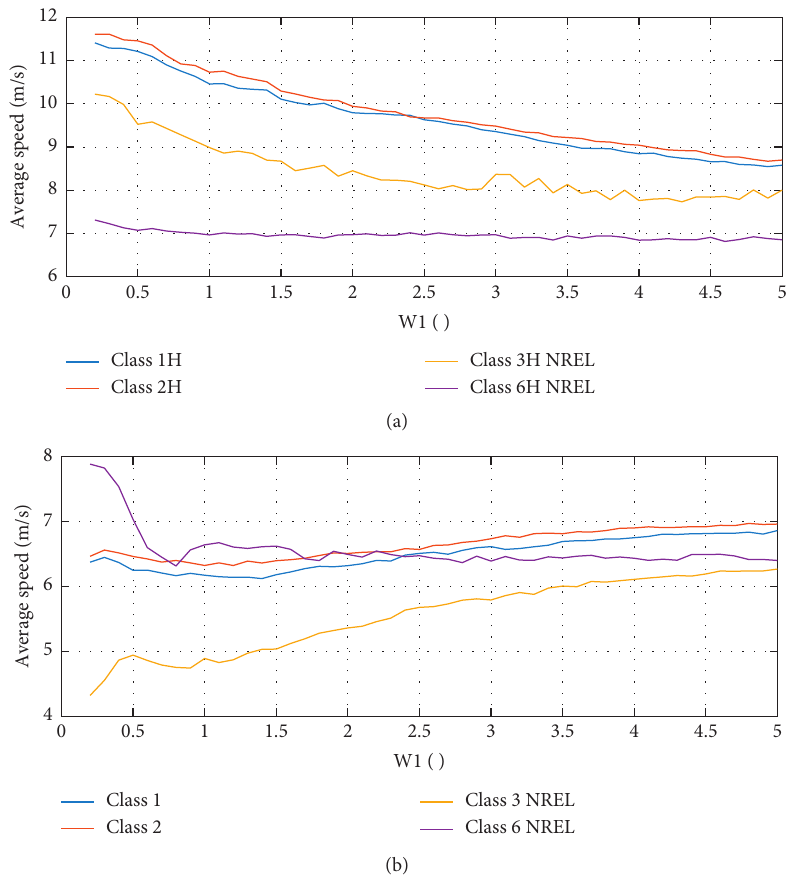
Figure 6: Average Speed versus β